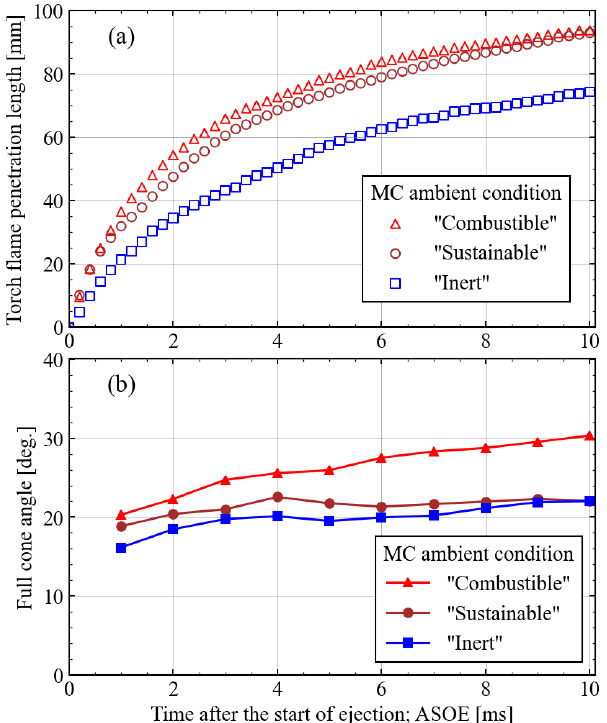
Fig. 7. Time history of (a) penetration, and (b) cone angle of torch flames under different main chamber gas conditions; “combustible” (lean CH 4 /air mixture), “sustainable” (artificial air), and “inert” (N 2 )